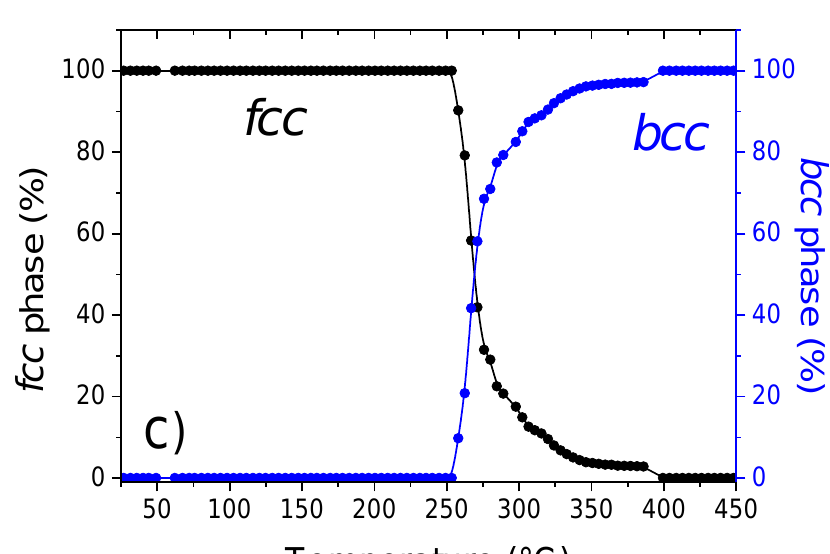
Figure 7. ( a ) In situ SR-XRD ( λ = 0.67156 Å) during hydrogen desorption from Ti 0.30 V 0.25 Cr 0.10 Zr 0.10 Nb 0.25 H 2 under dynamic vacuum from 25 ◦ C to 450 ◦ C with 5 ◦ C/min: the initial fcc dihydride and the desorbed bcc phase are marked with # and *, respectively. ( b ) Evolution of the lattice parameter of both fcc and bcc phases during rise of the